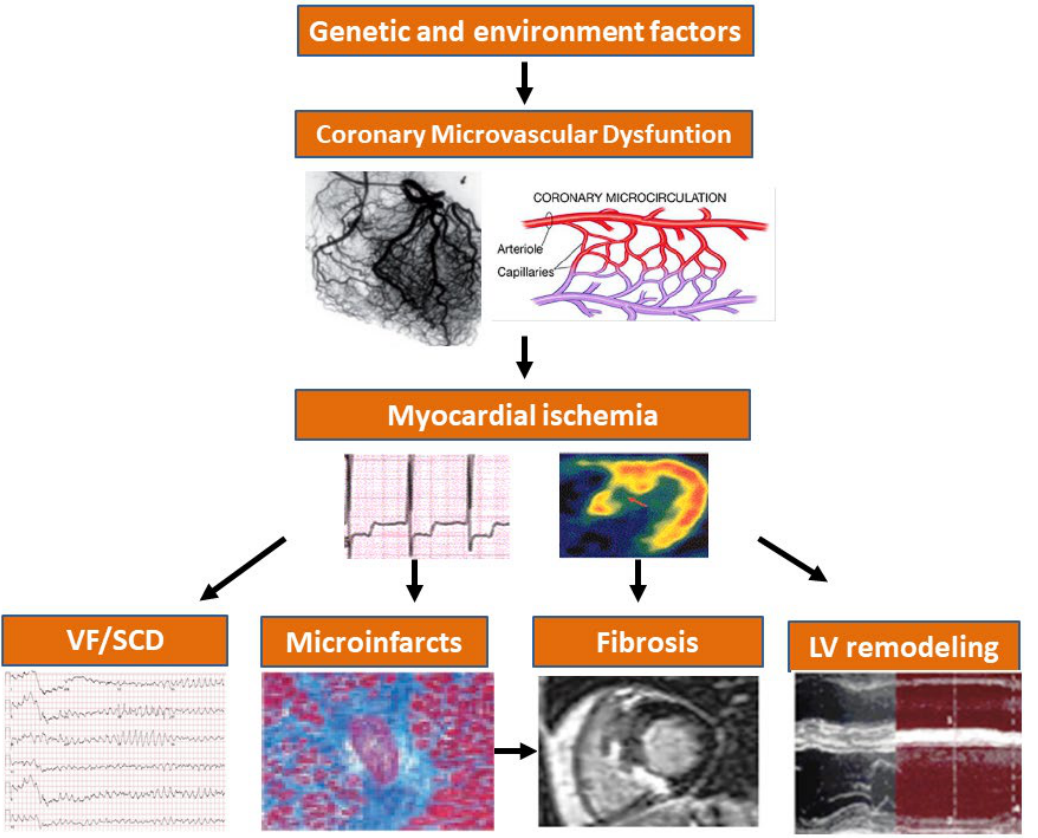
Figure 4. Proposed cascade of events in hypertrophic cardiomyopathy. Genetic and environmental factors cause abnormal coronary arteriolar remodeling and microvascular dysfunction leading to myocardial ischemia and fibrosis. The clinical consequences are either adverse left ventricular remodeling and heart failure or arrhythmias and sudden cardiac death.